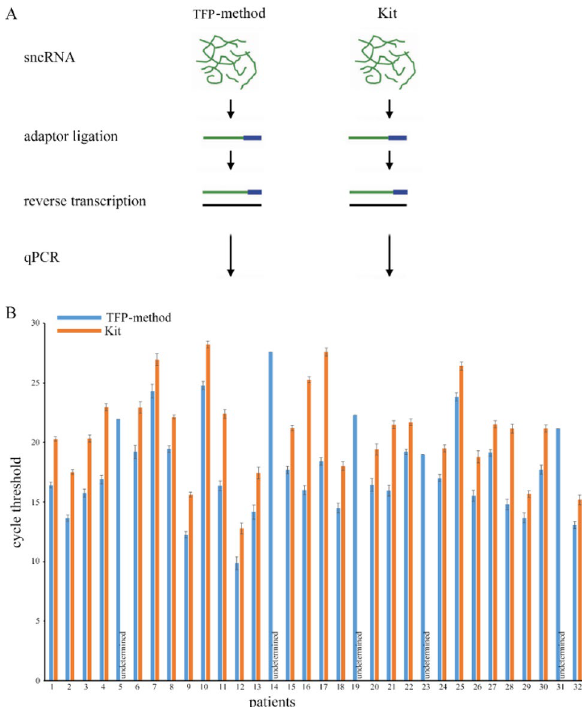
Figure 3. The steps for ligation and RT, and CT values of pfeRNA of 45 nt. ( A ) Five microliters of the extracted sncRNAs were ligated with adaptors in the 3 ′ end, and cDNA was synthesized by reverse transcription. ( B ) The specific CT values of pfeRNA of 45 nt from 32 clinical specimens. Three microliters of the synthesized cDNA, in a total volume of 20 µl, was used for qPCR detection. Undetermined means the levels of the target could not be detectable. All values are averages of six CT values from three independent repeats, and the error bars reflect the mean